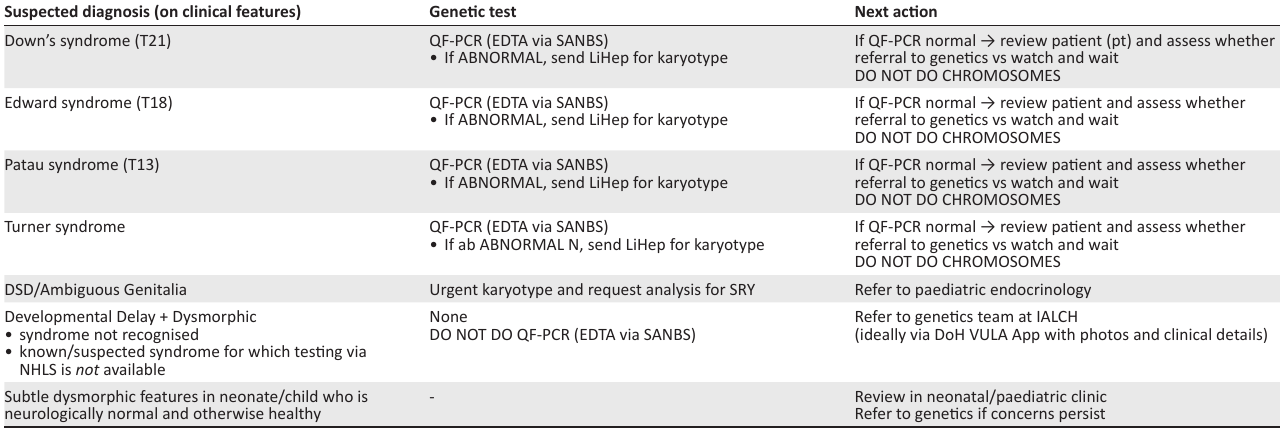
TABLE 1: Order of genetic testing. Suspected diagnosis (on clinical features)